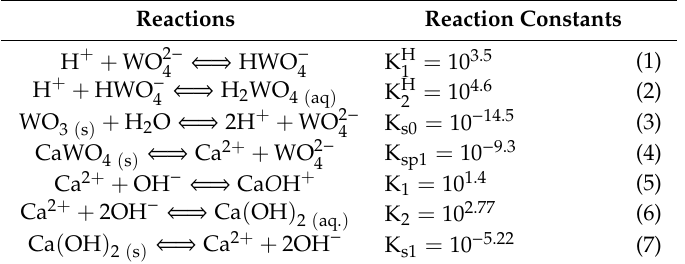
Table 2. Reactions and reaction constants in saturated scheelite slurry.